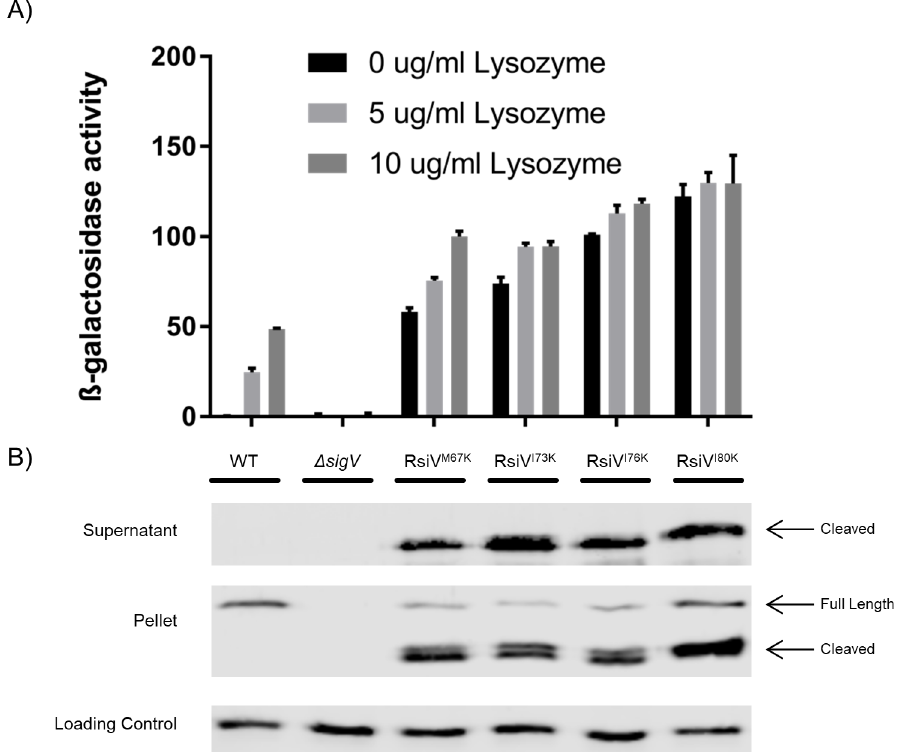
Fig 3. Lysine substitutions in the amphipathic helices lead to constitutive σ V activity. A . Various hydrophobic residues of the amphipathic helices were substituted with lysine residues to disrupt the charge of the amphipathic helix (M67K, I73K, I76K, I80K). These constructs were measured for σ V activity using a P sigV -lacZ reporter and a β - galactosidase assay. This experiment was done in triplicate and standard deviation is represented by error bars. B. The lysine substitution constructs (M67K, I73K, I76K, I80K) were further analyzed by western blot to measure RsiV degradation. Cells were grown to mid log. The pellet and supernatants were collected and samples were analyzed by western blot with α -RsiV 59-258 antibodies. Streptavidin IR680LT was used detect PycA which served as a loading control [67]. The color blot showing both pellet and loading control on a single gel is S5 Fig.